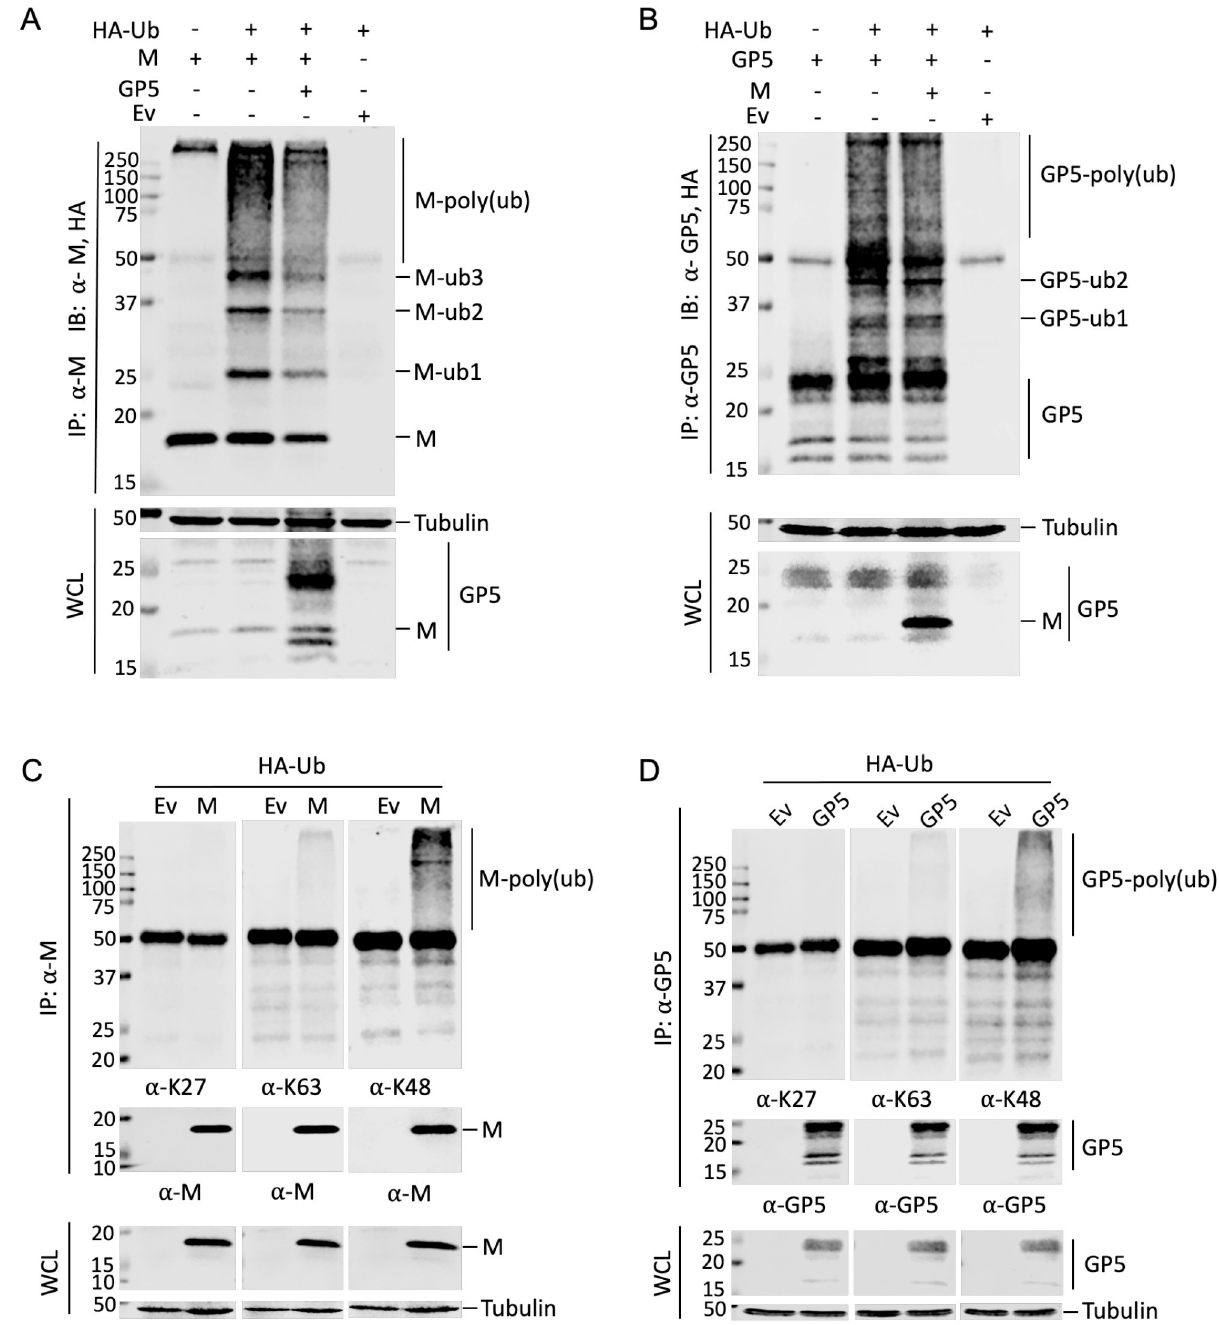
Fig 4. Polyubiquitination of PRRSV GP5 and M protein. HEK-293T cells were co-transfected with plasmids expressing HA-Ub, GP5 and/or M protein. At 42 h post transfection, proteasome inhibitor MG132 was added. At 48 h post transfection, cell lysates were collected for IP analysis. ( A and C ) Lysates were immunoprecipitated with anti-M pAb. ( B and D ) Lysates were immunoprecipitated with anti-GP5 pAb. Western blot analysis was conducted with the whole cell lysate or immunoprecipitated proteins using the mAb against HA, antibodies specifically recognize K27-, K48- or K63-linked polyubiquitin chains, or a specific Ab to each viral protein as labeled for each panel. IP: immunoprecipitation; IB: immunoblotting; WCL: whole cell lysates; Ev: empty vector.